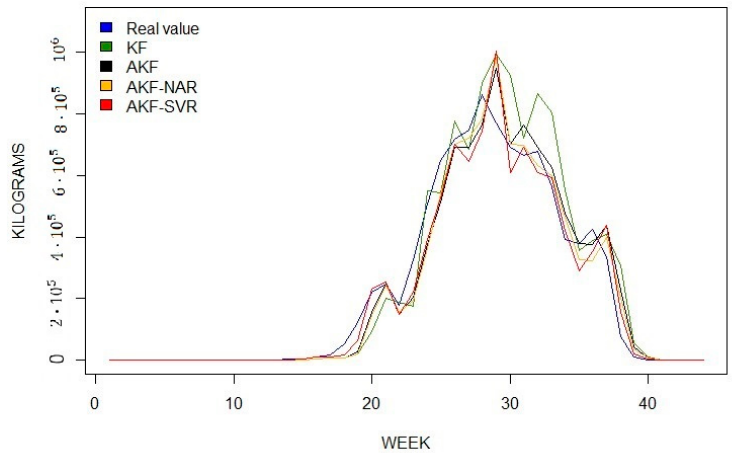
Figure 1. Prediction charts for strawberries: 2019–2020 (weekly).